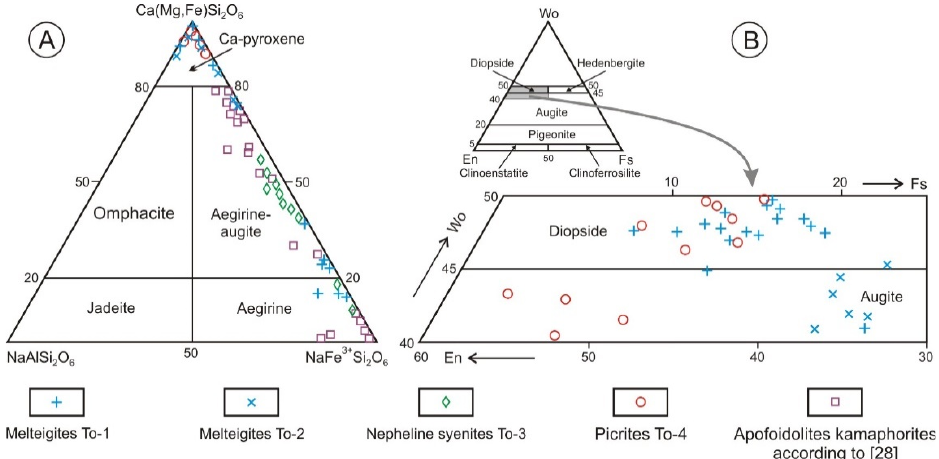
Figure 4. Composition of pyroxenes on Ca–Mg–Fe–pyroxenes–jadeite–aegirine ( A ) and En–Wo–Fs ( B ) diagrams.